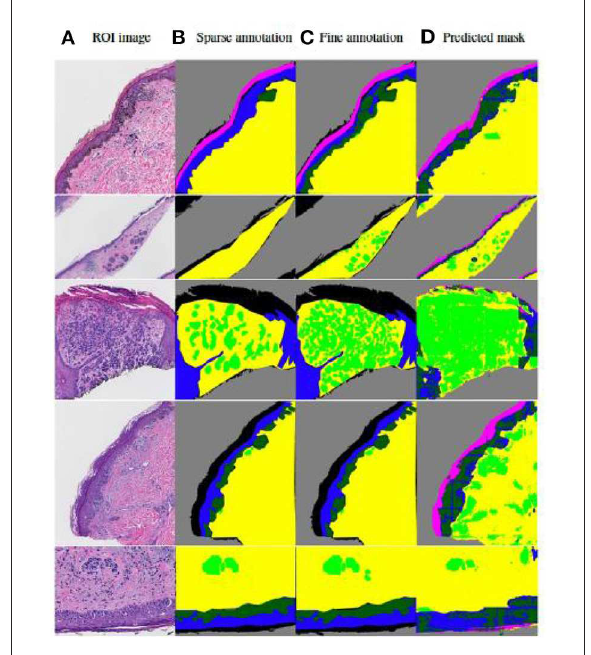
FIGURE5 Visualization of results by our published two-step segmentation method (Nofallah et al., 2022b). (A) Examples of original image; (B) Sparse expert annotation; (C) Fine-detailed epidermal and dermal nest annotation by expert for evaluation; (D) Segmentation results by our published work. The annotation and segmentation images contain the dermis ( DM -yellow), epidermis ( EP -blue), stratum corneum ( COR -pink), background ( BG -gray), dermal nests ( DMN -light green), and epidermal nests ( EPN -dark green).